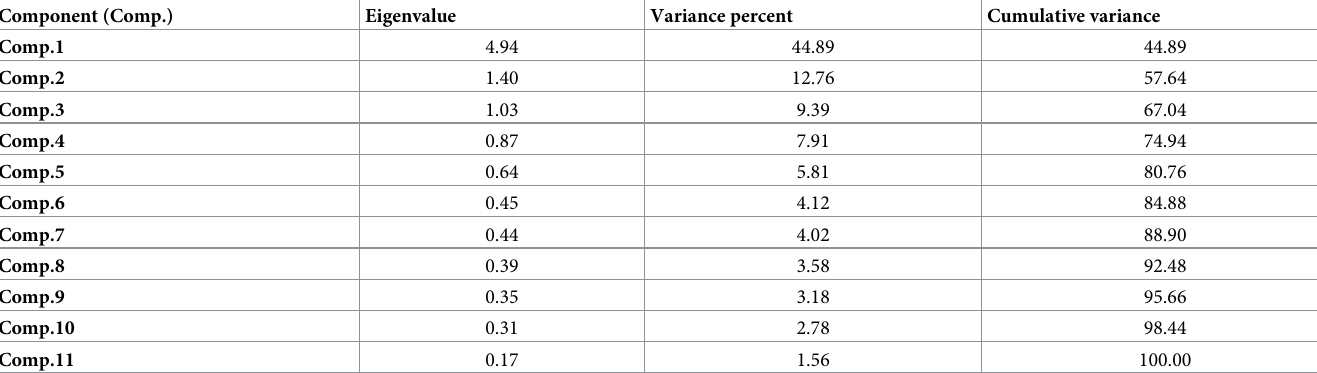
Table 2. Eigenvalues, variance percentages and cumulative variances for the components. Component (Comp.)